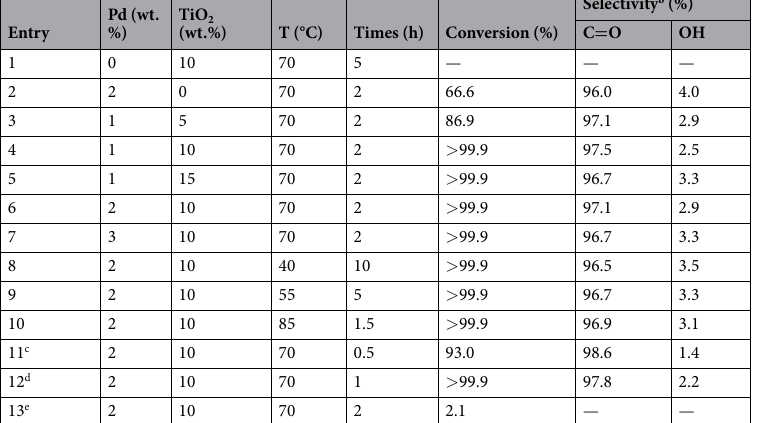
Table 1. Hydrogenation of phenol with Pd/ Ⓕ -TiO 2 /AC catalyst under various conditions a . a Reaction conditions: phenol (0.353 g, 3.75 mmol), Pd (0.5 mol% relative to phenol), ichlomethane (20 mL), P H 2 (5 bar), unless otherwise noted. b C = O indicates cyclohexanone and C–OH indicates cyclohexanol. c n Pd : n phenol =